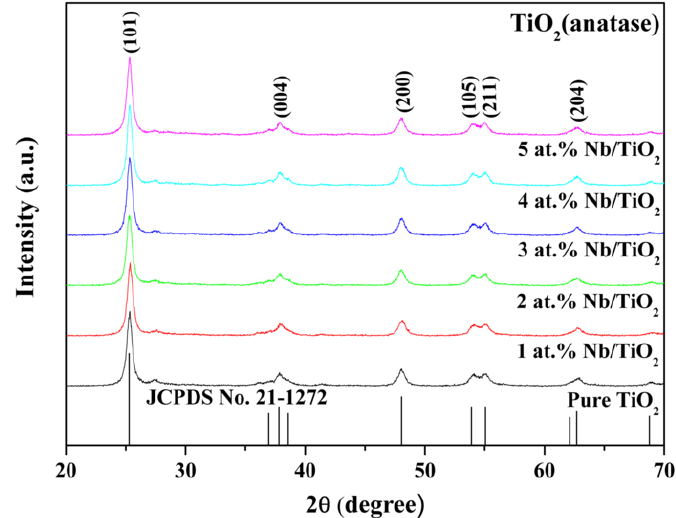
flame-made samples. 2